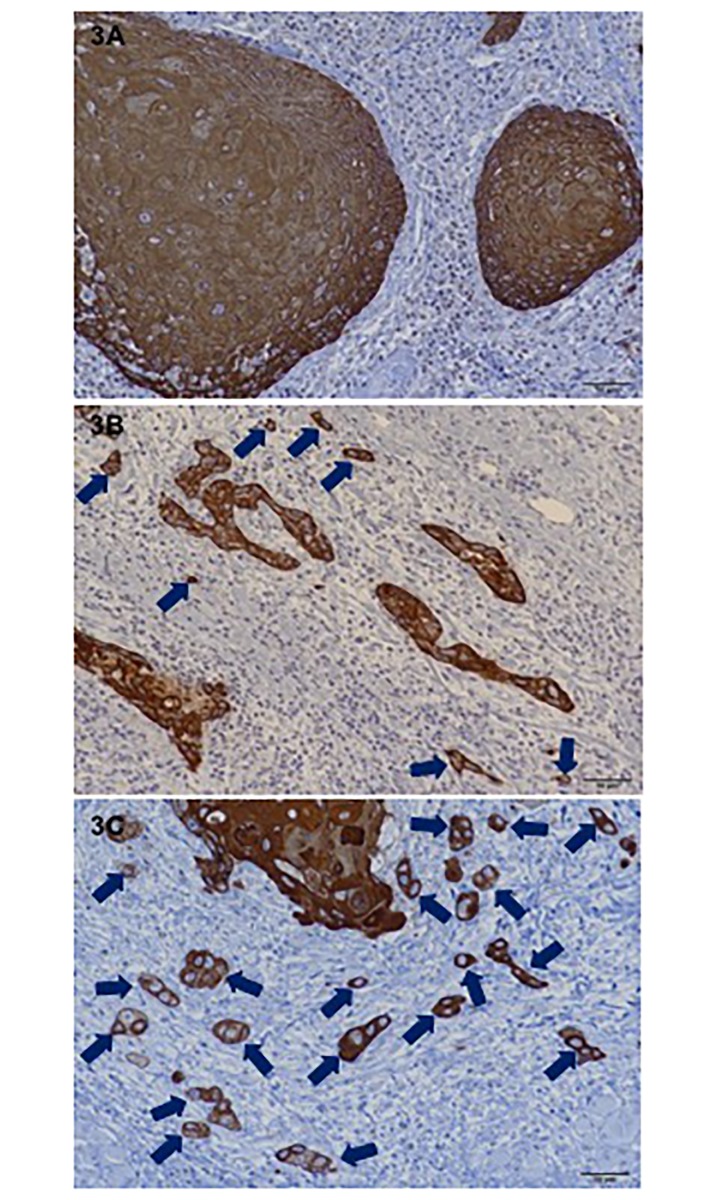
Representative photographs of intensity of tumor budding (immunohistochemical pancytokeratin staining, x200 magnification).(3A) Low intensity of tumor budding (<5 buds), (3B) intermediate intensity of tumor budding (≥5~<10 buds), and (3C) high intensity of tumor budding (≥10 buds).